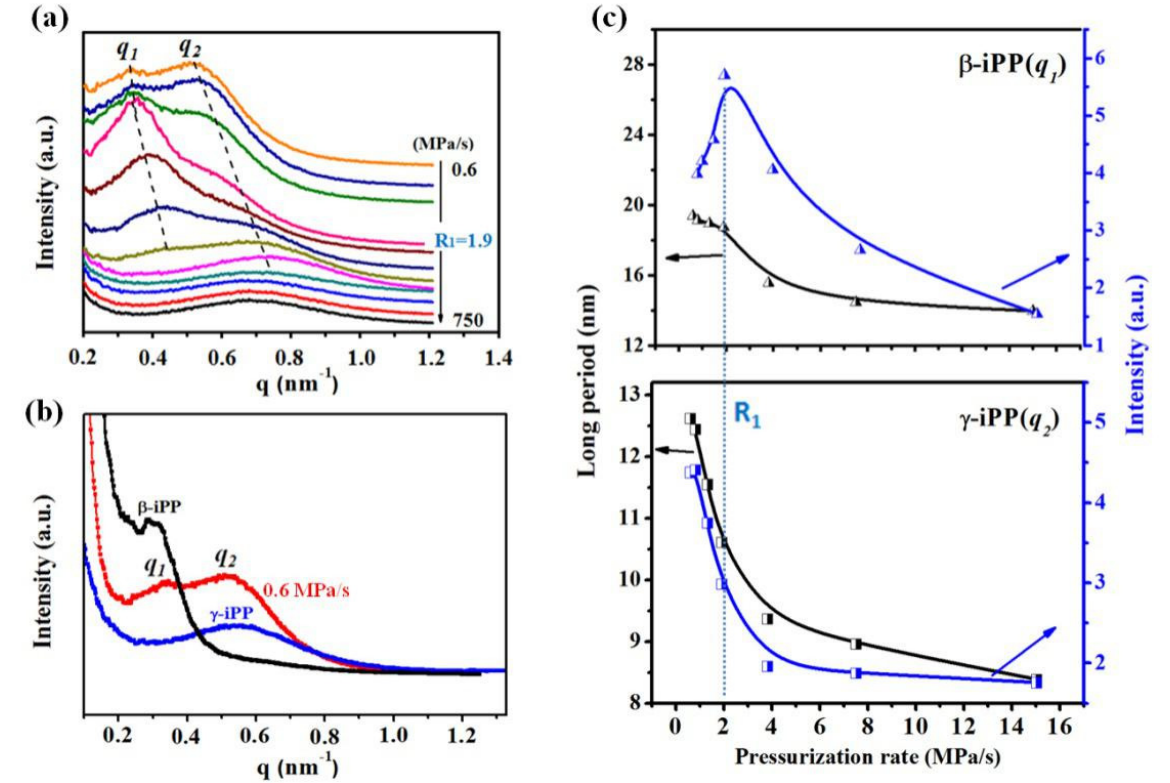
Figure 5. ( a ) Selected SAXS profiles of the iPP0.2 samples solidified by pressuring to 1.7 GPa at different pressurization rates; ( b ) Comparison of the SAXS profiles between pure β -, γ -iPP and the iPP0.2 samples prepared by pressuring at 0.6 MPa/s; ( c ) Changes in the maximal intensity of γ - and β -iPP as a function of pressurization rates.